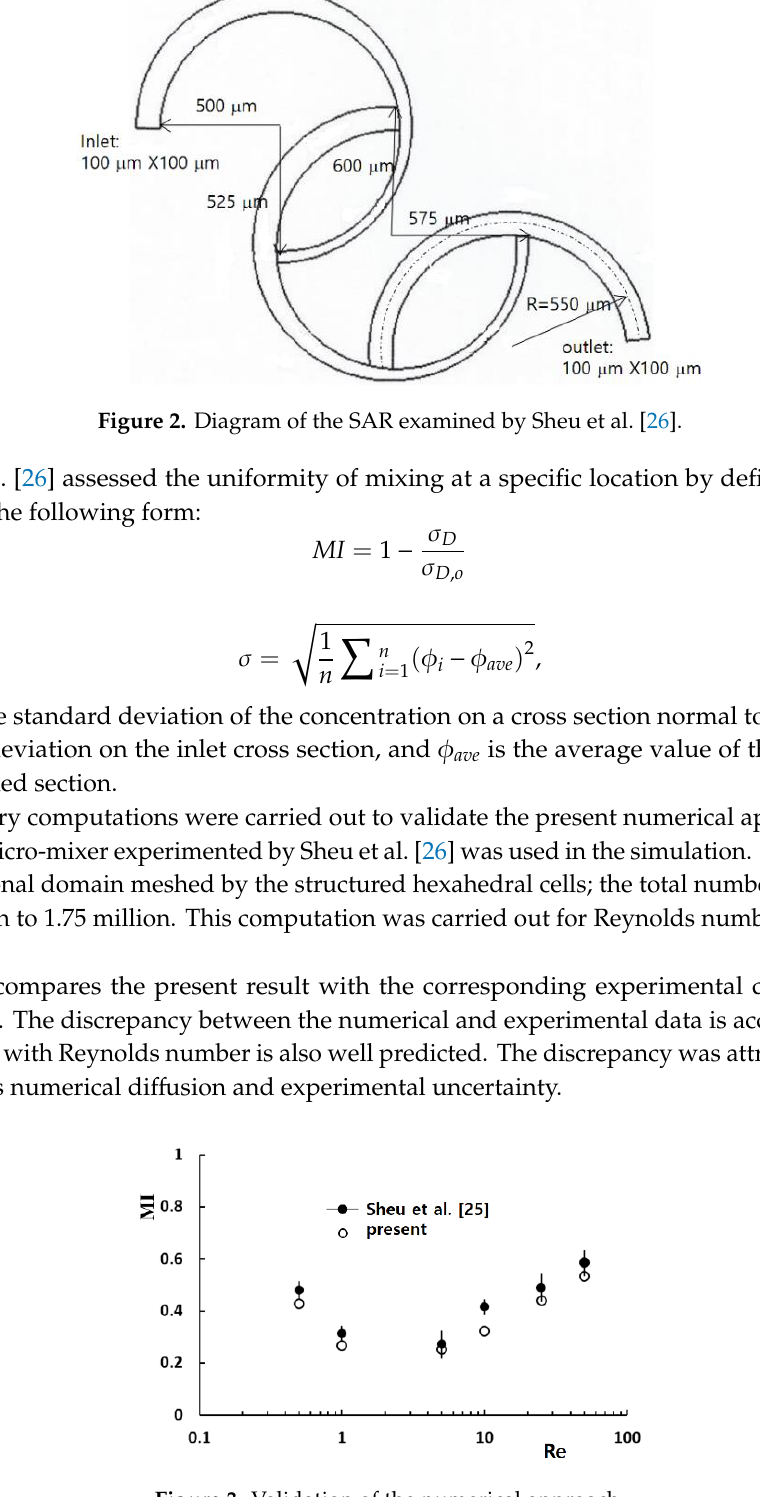
Figure 3. Validation of the numerical approach.